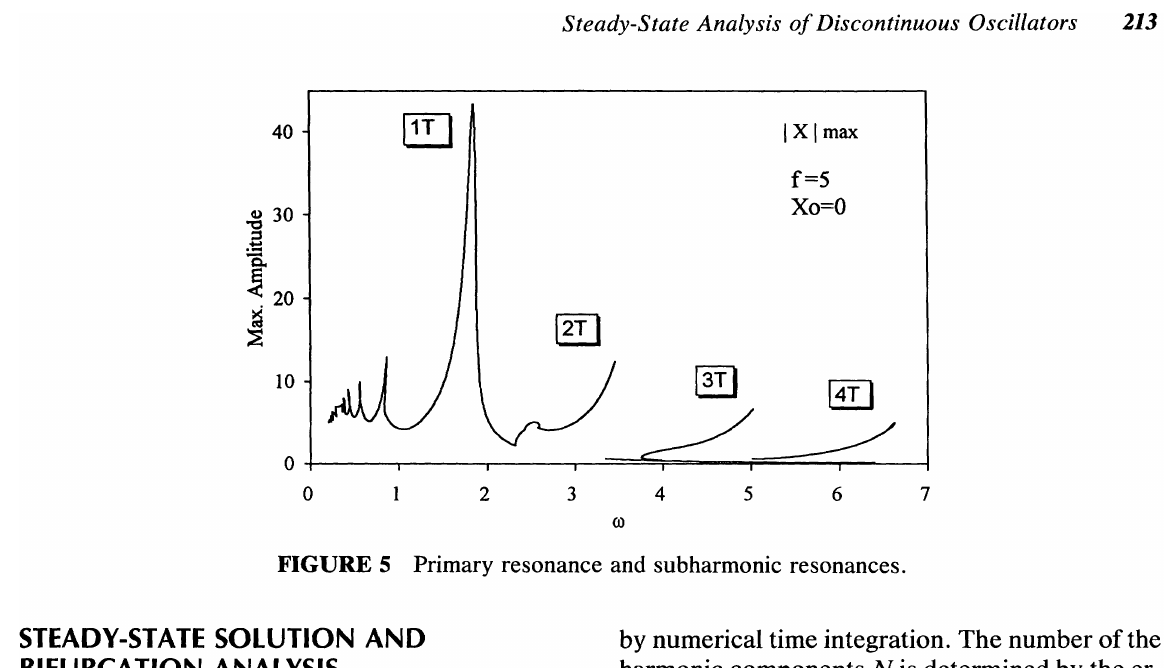
FIGURE 5 Primary resonance and subharmonic